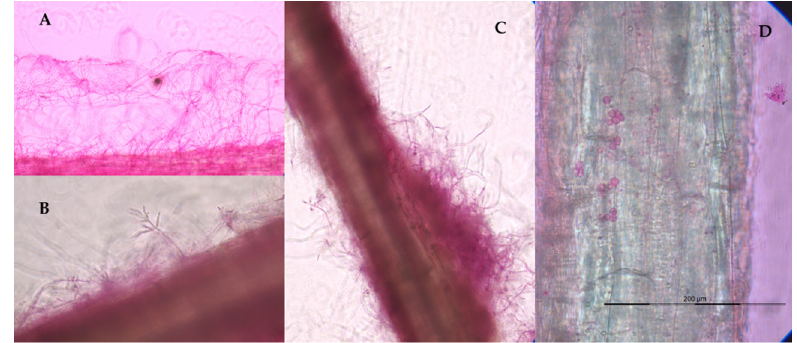
Figure 4. ( A ) Colonization of pepper and tomato roots by T. aggressivum f. europaeum. ( C ) Mycelium in pepper root (100×). ( B ) Conidiophores and mycelium in tomato root (100×). ( D ) Chlamydospores in pepper root (200×).